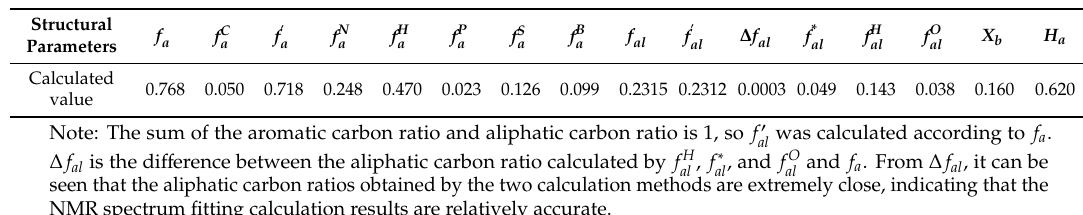
Table 5. The 13 C-CP / MAS NMR structural parameters of